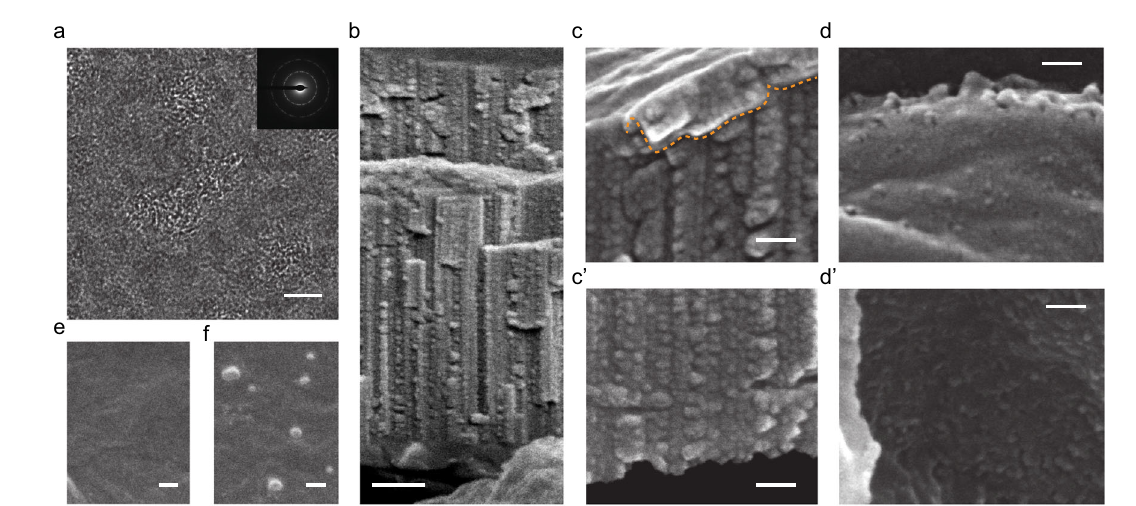
b low and c , c ’ high magni fi cation. The bent surface layer of the GO fi lm is marked withorangedashedlines. d , d ’ SEMimagesofthe d topand d ’ bottomsurfaceofthe GO fi lm. e , f SEM images of GO-Z fi lms irradiated with different doses of 61MeVV ions. The scale bars are a 5nm, b 200nm, c – f